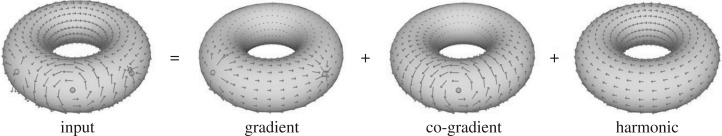
Example of a Hodge–Helmholtz decomposition of a PCVF on a torus into gradient, co-gradient and harmonic field.